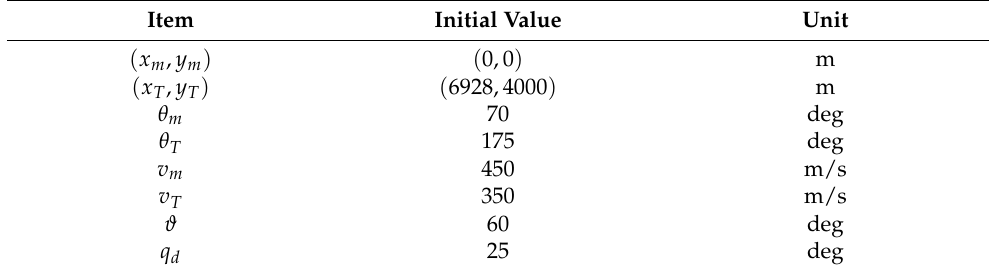
Table 2. Initial parameters of the missile and target.